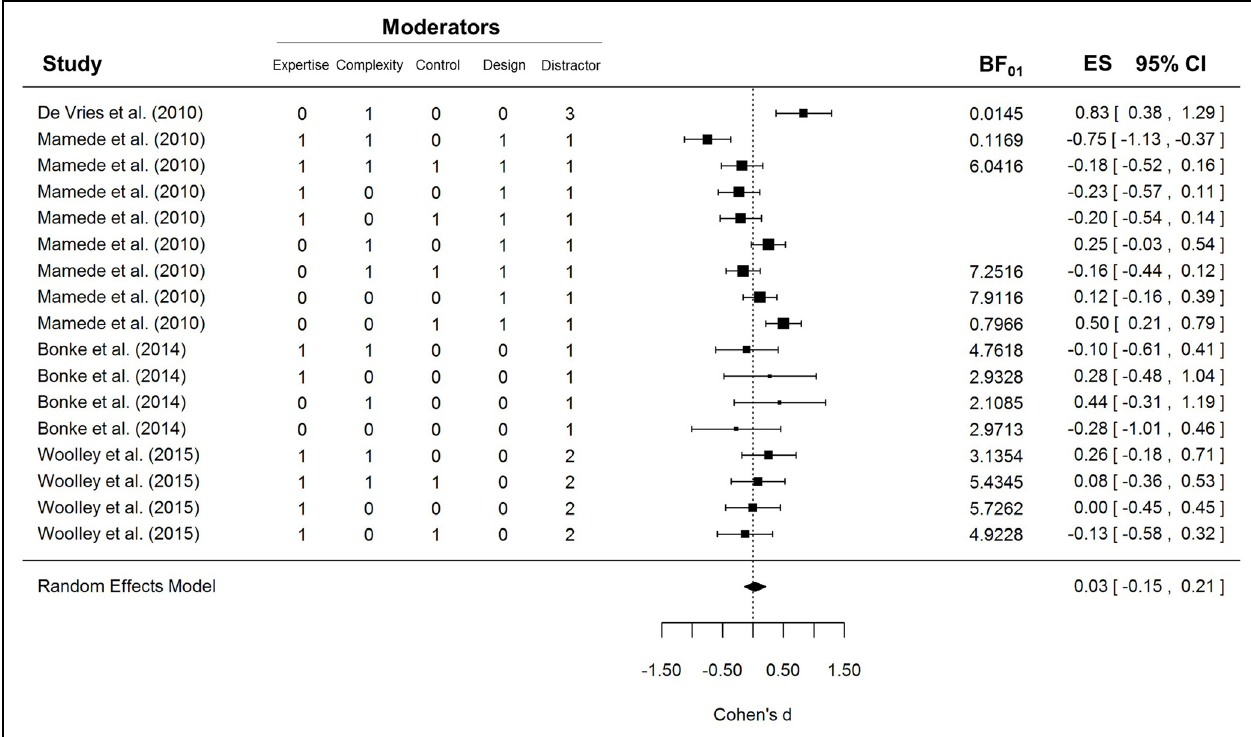
FIGURE 1 | Forest plot of the first meta-analysis. Five moderators were included: Expertise, i.e., whether participants were novices (0) or experts (1); Complexity, i.e., whether the case materials were simple (0) or complex (1); Control, i.e., whether the UT condition was compared to a conscious-thought